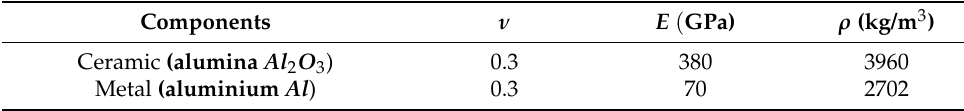
Table 1. Material characteristics of Al 2 O 3 and Al [38].